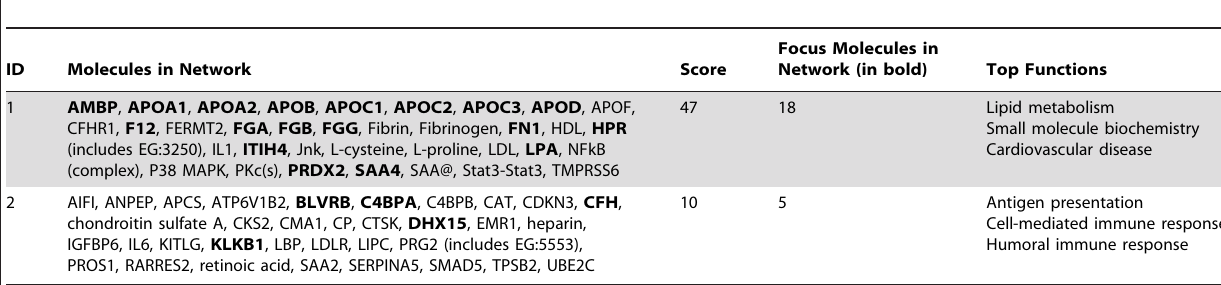
Table 3. Interaction networks defined by Ingenuity Pathways Analysis.